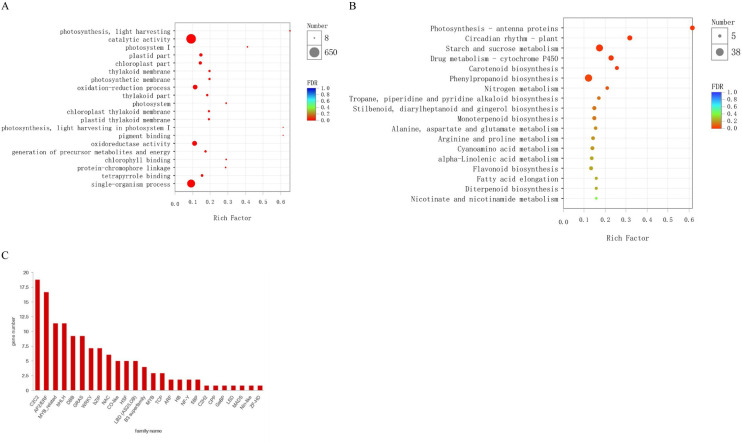
Annotation and pathway analyses of the identified DEGs.(A) GO enrichment analysis of common DEGs. (B) The scatter plot of enriched KEGG pathways of DEGs. (C) Number of genes from TF families in the common DEGs.